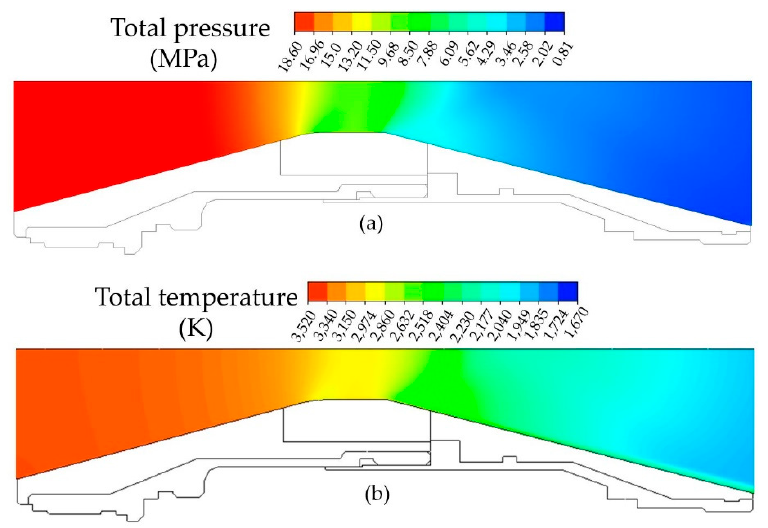
Figure 16. The loads of ( a ) total pressure and ( b ) total temperature at 1.2 s, applied to the